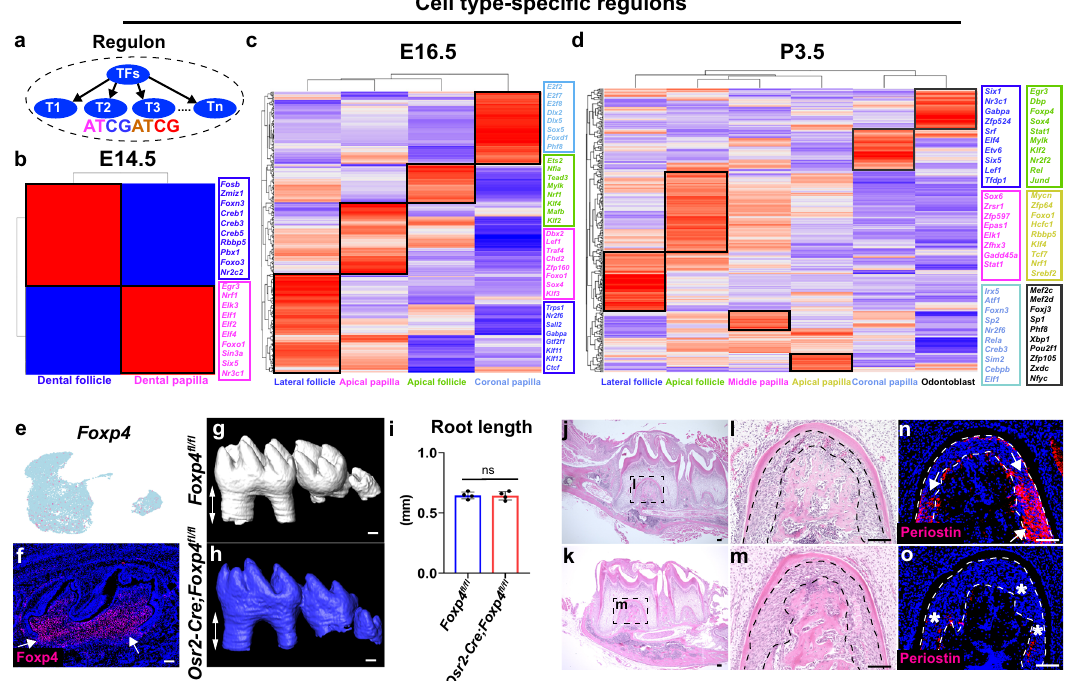
Fig. 8 | Gene regulatory networks determine dental mesenchymal lineages developmentduringmousemolarformation.a Schematicdrawingofaregulon, TFs, transcription factors, T, target gene. b – d Heatmap of cell type-speci fi c reg- ulons and selected top enriched regulons in the cell populations of the dental mesenchymeatE14.5,E16.5andP3.5. e , f FeatureplotandimmunostainingofFoxp4 in the mouse molar atP3.5 ( n =3). g – i CT scanning and quantitative analysisofthe toothrootlengthin Foxp4 fl / fl and Osr2-Cre;Foxp4 fl / fl molarsatP16.5,ns,nosigni fi cant